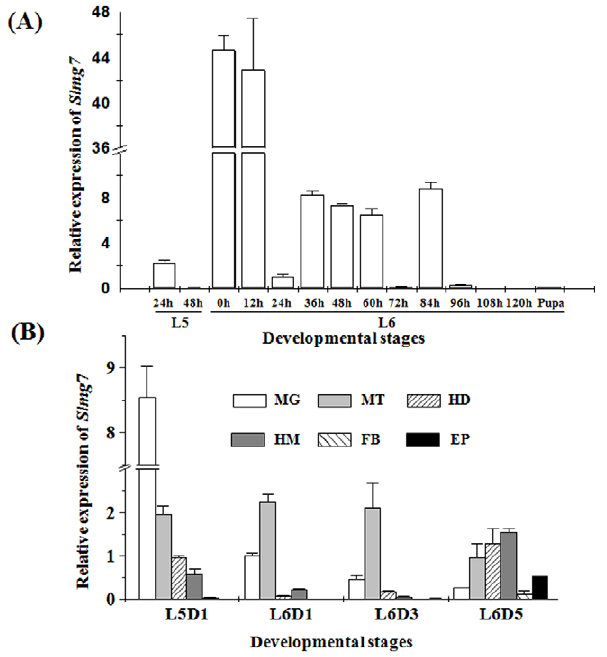
Figure 7. Quantitative real-time RT-PCR (qRT-PCR) analysis of Slmg7 in different stages and tissues of S.litura . (A) Analysis of Slmg7 expression in the midgut from 5 th instar to pupal stages. (B) Analysis of Slmg7 expression in the midgut, Malpighian tubules, head, hemolymph, fat body and epidermis at 5L1D, 6L1D, 6L3D and 6L5D. The relative expression was calculated by comparing the expression of the Slmg7 gene over the GADPH (glyceraldehyde-3-phosphate dehydroge- nase) gene using the equation of 2 2 DD C T [16]. Values are presented as means 6 SD (standard deviation) (n=9). L5 and L6: 5 th and 6 th instar larvae, respectively; MG: midgut; MT: Malpighian tubules; HD: head; HM: hemolymph; FB: fat body; EP: epidermis.